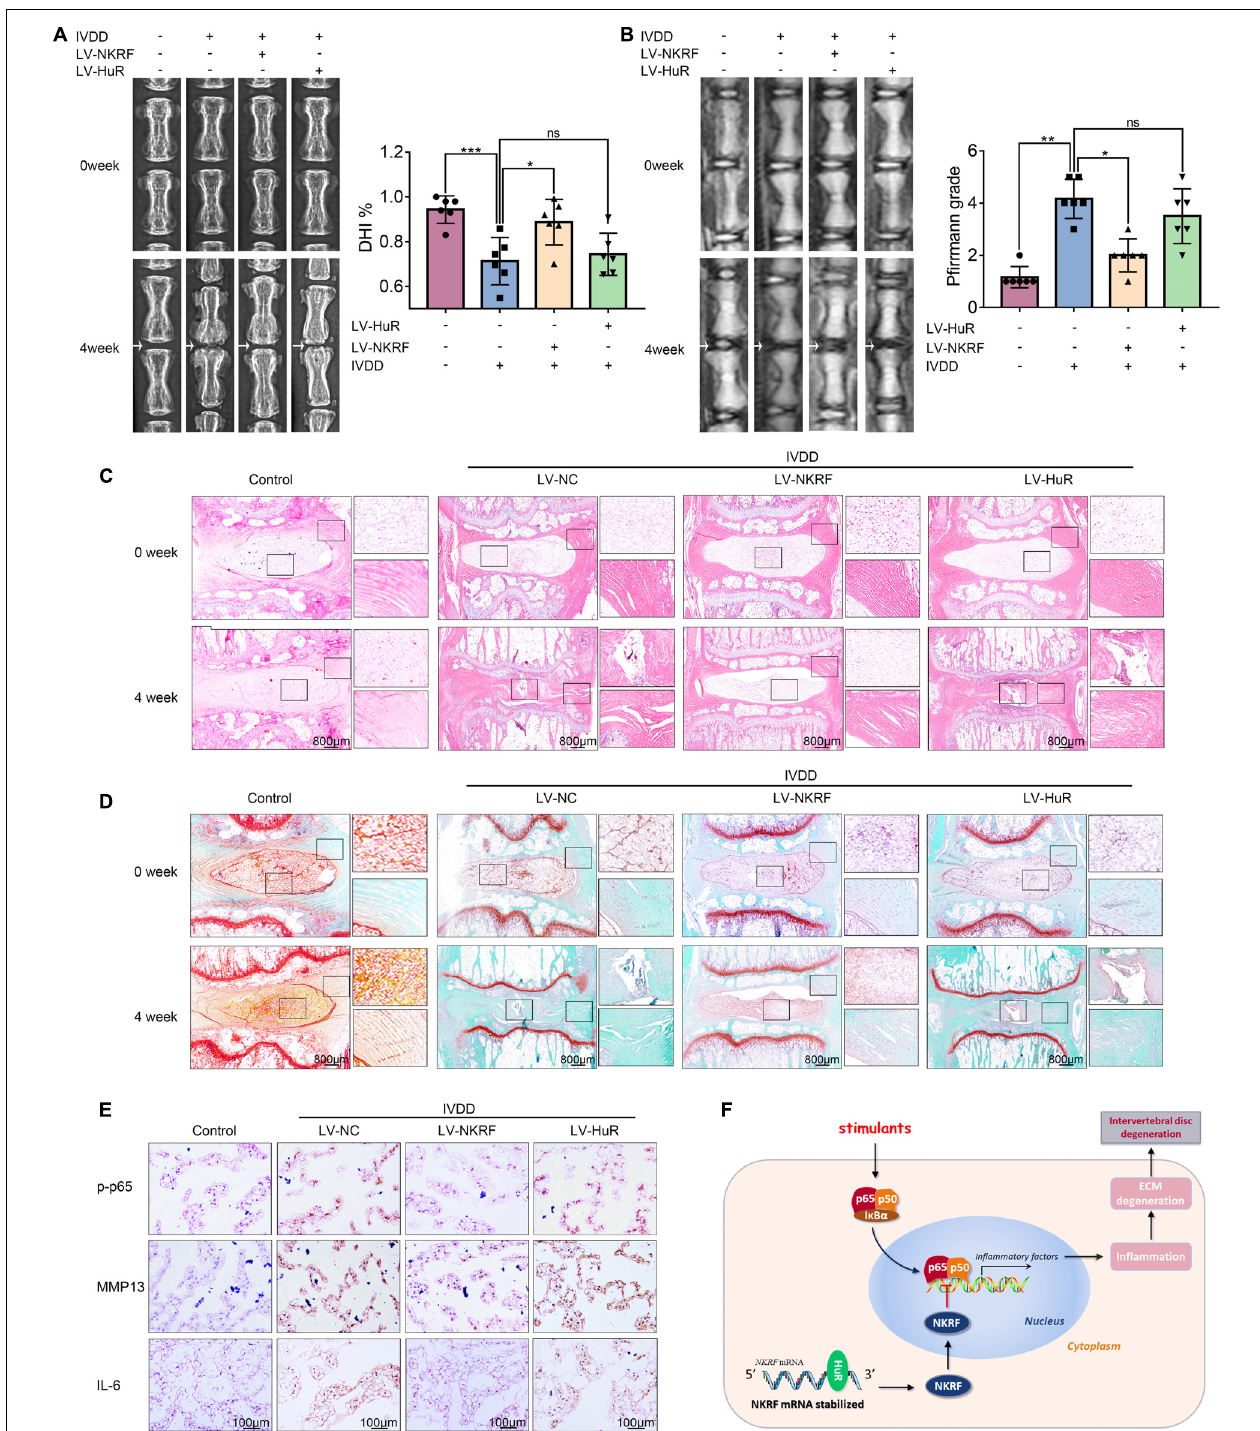
FIGURE 6 | NKRF, but not HuR, overexpression ameliorates the process of IVDD in vivo . The rats were injected lentivirus into the intervertebral disc. (A) The X-ray of a rat-tail disc at 4 weeks after disc puncture surgery in normal and IVDD rats, with or without lentivirus transfection (white arrows); the disc height index (DHI) of a rat-tail disc. (B) T2-weighted MRI of a rat-tail disc at 4 weeks after disc puncture surgery (white arrows); The respective Pfirrmann grade scores of a rat-tail disc. (C,D) Representative hematoxylin and eosin staining and Safranin O-Fast Green staining of NP tissues in normal and IVDD rats (bar: 800 µ m). (E) The immunohistochemical staining of p-p65, MMP13, and IL-6 in intervertebral disc sections (bar: 100 µ m). (F) Schematic illustration of the research. NKRF inhibits inflammation and ECM degradation in IVDD via NF- κ B signaling pathway; mechanism study revealed that HuR prompts NKRF mRNA stability via binding to the AU-rich element. All data were shown as mean ± SD. * p < 0.05, ** p < 0.01, *** p < 0.001.